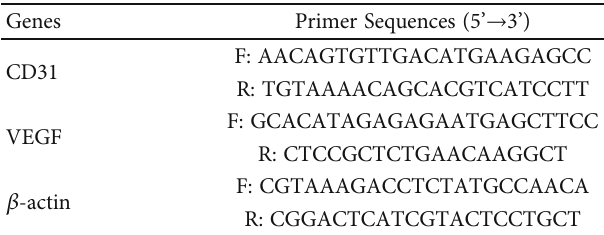
Table 1: Primer sequences used for qRT-PCR. Genes Primer Sequences (5 ’ → 3 ’